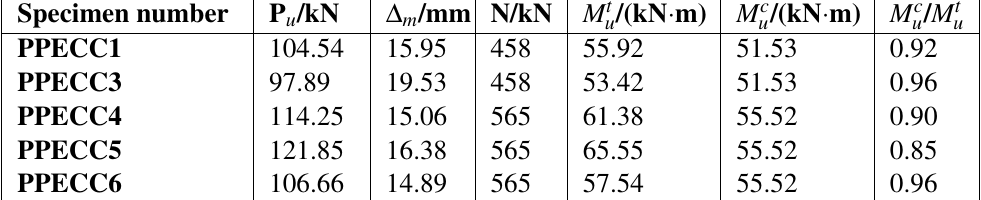
Table 2 Comparison of test results and calculated